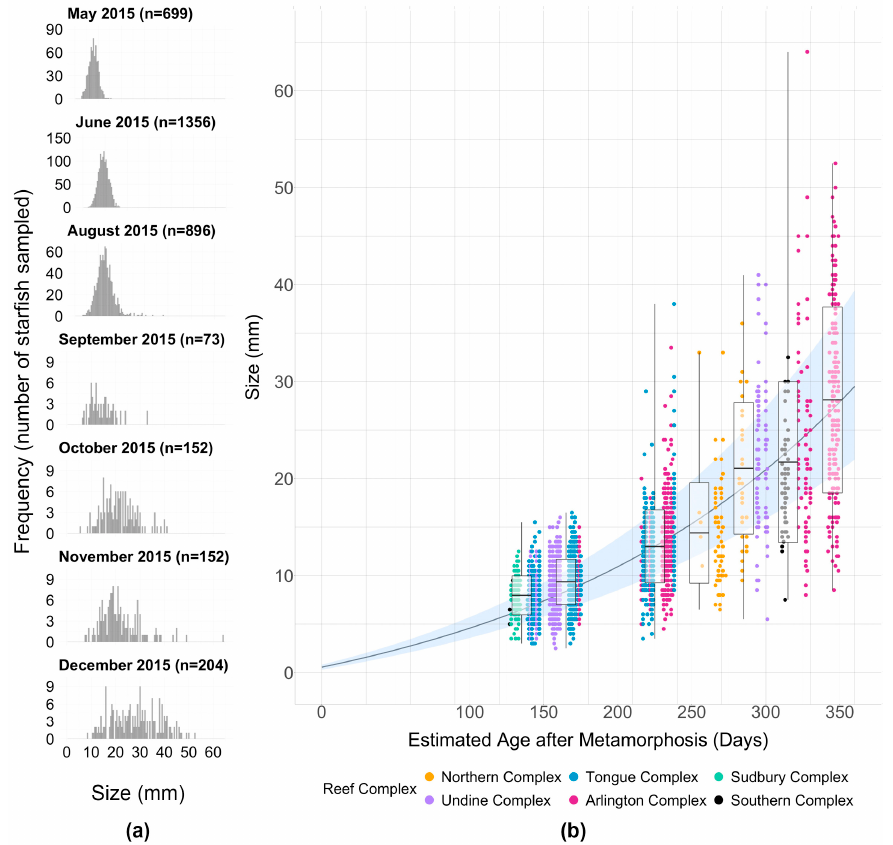
Figure 2. ( a ) Monthly size–frequency distributions of juvenile crown-of-thorns starfish sampled during May–December 2015; ( b ) Fitted growth curve ( m2 Size at Age 0=0.56 , black line) and combined 95% confidence interval (light blue) for the 0+ year crown-of-thorns starfish cohort sampled in the northern Great Barrier Reef (GBR). The combined 95% confidence interval is formed by the lower and upper bounds of the 95% confidence interval of m2 growth models with size at age 0 set to 0.30 mm and 0.82 mm, respectively. Individual starfish of the 2015 cohort are depicted as points, and the colours indicate the reef complex (see Figure 1). Each boxplot (by sampling month) is characterised by a mean size (horizontal middle line), ± one standard deviation (rectangle), and minimum and maximum size (vertical line). The vertical lines of the grid indicate 30-day intervals.